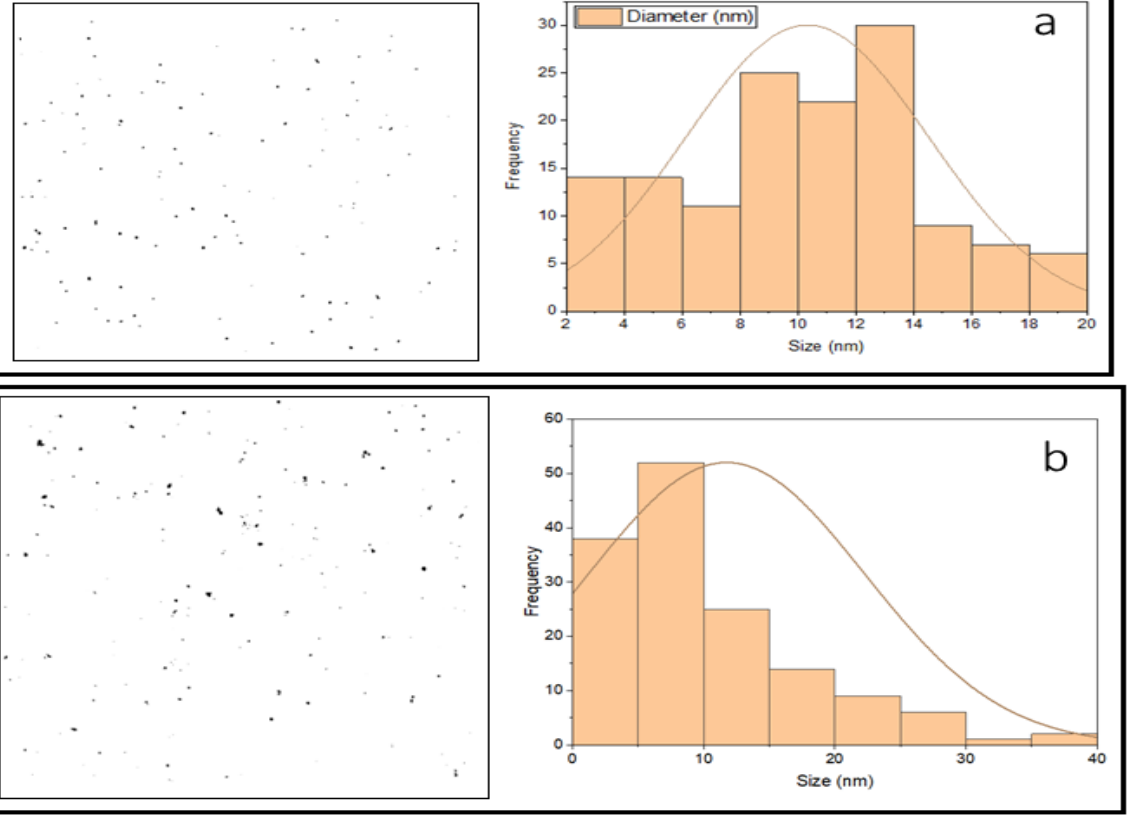
Figure 15. SEM images and histogram of percent frequency distribution of the GNPs prepared at different temperatures. ( a ) at 328.15 K, ( b ) at 291.15 K.